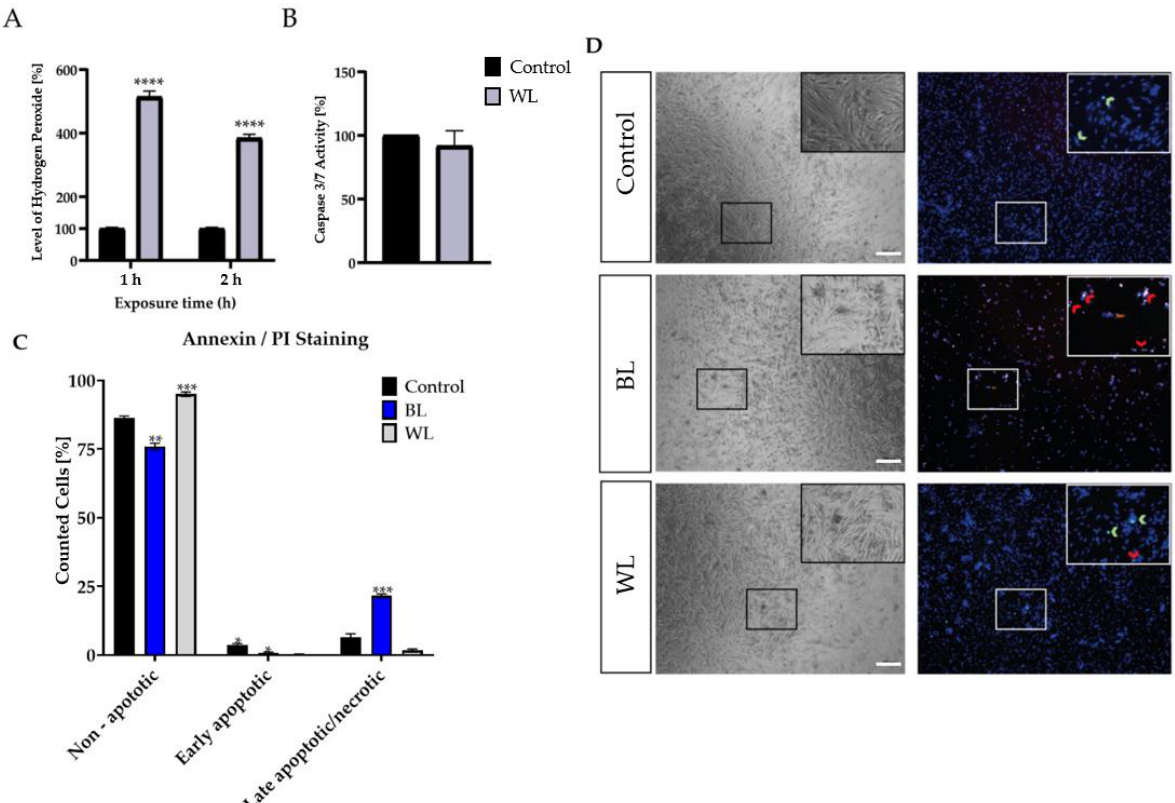
Figure 2. Blue light exposure enhanced cell death in Müller cell-derived cells in contrast to white light. ( A ) H 2 O 2 levels in white light (WL, 30 mW/cm 2 )-exposed porcine Müller cell-derived cells (MCs) were significantly increased after 1 or 2 h of WL exposure. ( B ) MCs showed no increase in caspase 3/7 levels 6 h after WL exposure; n = 10, three independent experiments; controls were set to 100%. ( C ) BL- or WL-exposed MCs were stained with annexin V/PI and demonstrated significantly more (late) apoptotic cells compared to unexposed cells. ( D ) Representative pictures of annexin/PI staining displayed increased PI (red) and annexin V (green) staining in BL-exposed MCs 24 h after exposure. Less PI and annexin V staining was observed in WL-exposed MCs. Red arrows indicate late apoptosis/necrosis, while green arrows indicate early apoptosis; n = 15, analyzed using ImageJ. Bar graphs represent mean values as percentages and the SEM. Statistical differences are indicated as follows: * p < 0.05, ** p < 0.01, *** p < 0.001, and **** p < 0.0001 compared to the control, according to Welch’s Student‘s t - test or Welch’s one -way ANOVA. Scale bar = 200 μm.